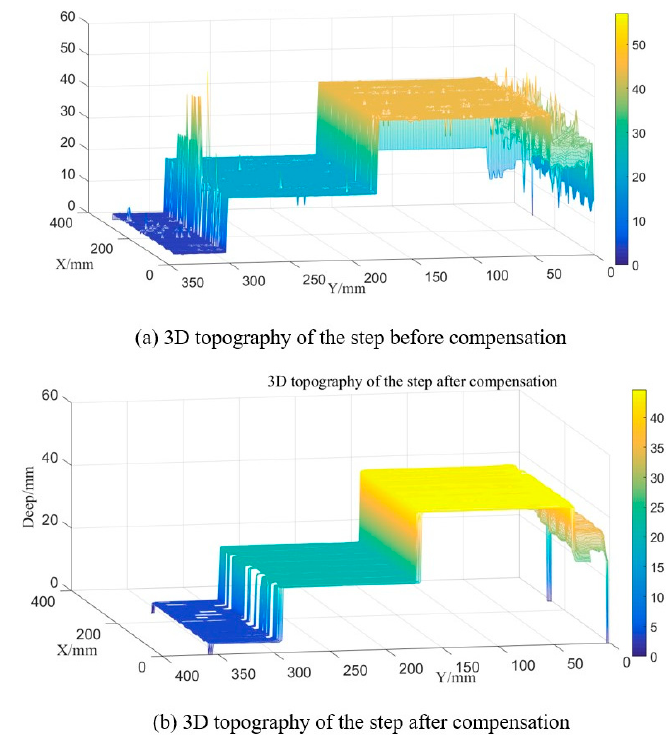
Figure 16. Three-dimensional step topography restoration map. Table 1. Measurement precision of step distance before and after calibration (unit: